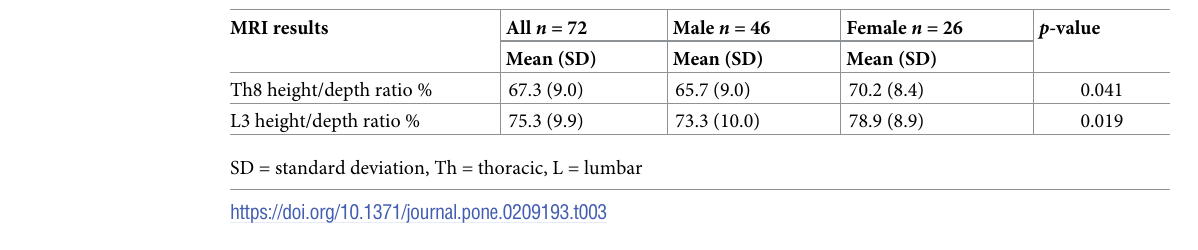
Table 3. Mean values of Th8 and L3 vertebrae measurements in males and